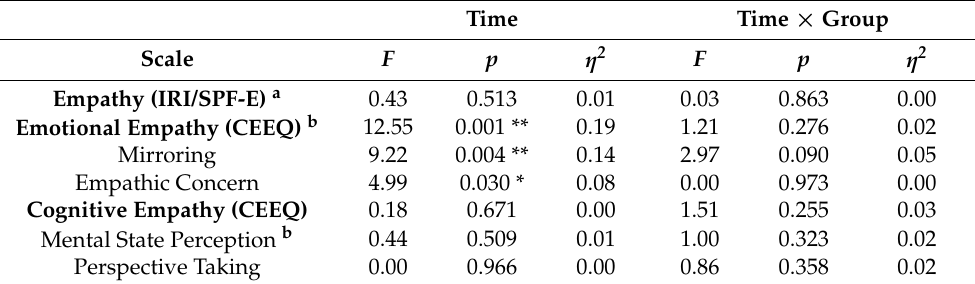
Table 3. Results of the repeated measures ANOVA of all measured main outcomes of empathy. Time Time × Group Scale F p η 2 F p η 2 Empathy (IRI/SPF-E) a 0.43 0.513 Emotional Empathy (CEEQ) b 12.55 0.001